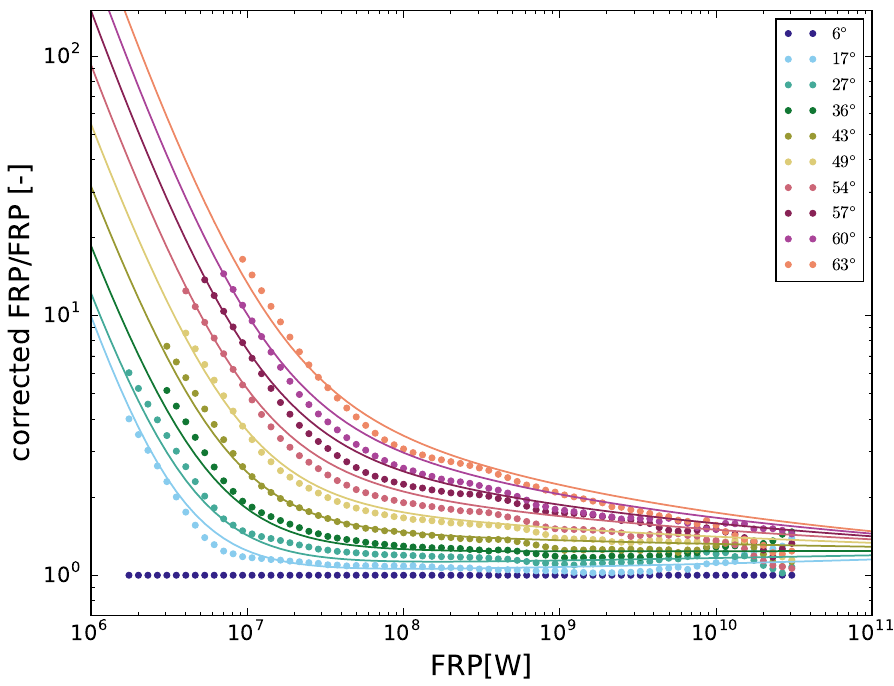
Figure 1. The correction factors derived after mapping the cumulative distribution function (CDF) of the off-nadir and nadir gridded-Fire Radiative Power (FRP) observations from 2016 and at 1 ◦ spatial resolution. The dots represent the discrete correction factors ζ i , j while the lines depict the continuous correction function ζ ( (cid:36) , θ ) for each viewing angle. The discrete correction factors ζ i , j can also be used as a look-up